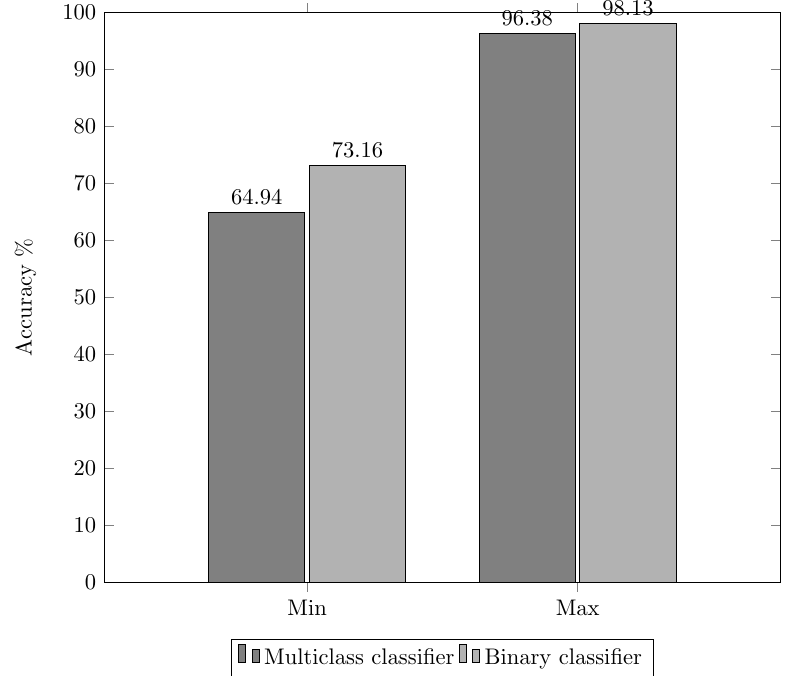
Figure 9. Comparison of minimum and maximum accuracies for both, binary and multi-class